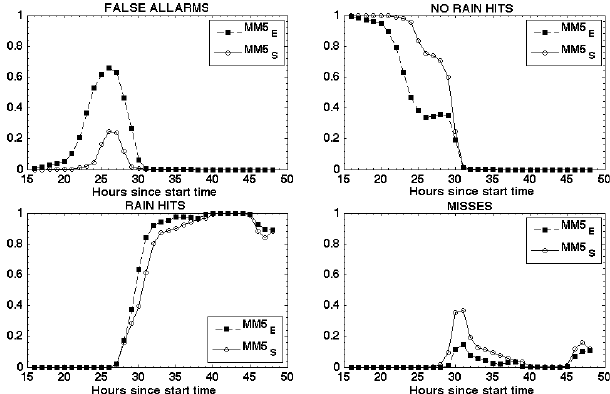
Fig. 10. Time evolution (hours since start time) of false alarms (up- per left panel), hits of grid points where there is no rain (upper right panel), hits of rain (lower left panel) and misses (lower right panel), for the MM5 E and MM5 S